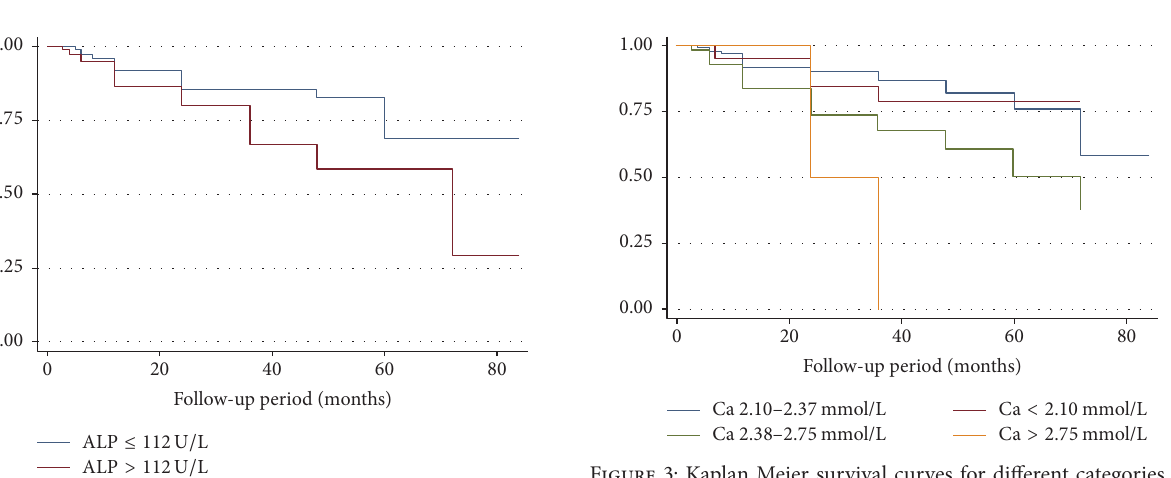
Figure 1: Kaplan Meier curve comparing patients in the high alkaline phosphatase to low alkaline phosphatase group ( 𝑃 = 0.01 ).